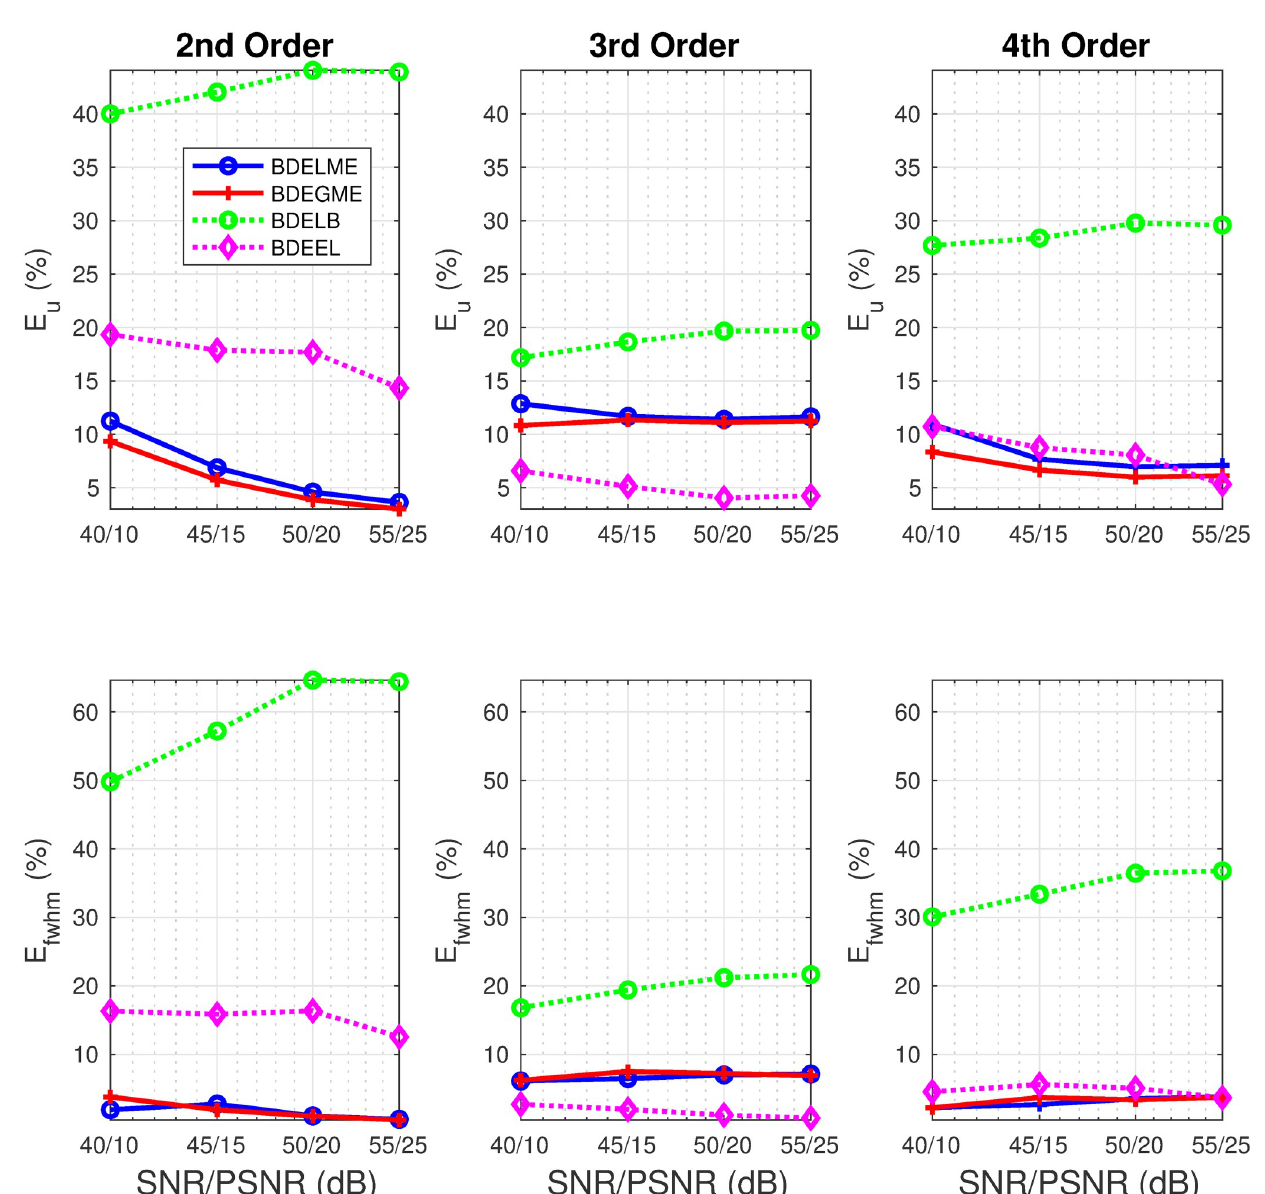
Fig 6. Performance metrics in synthetic evaluation with 2nd, 3rd and 4th order FluoIR models: (top-row) E u , and (bottom row) E fwhm .